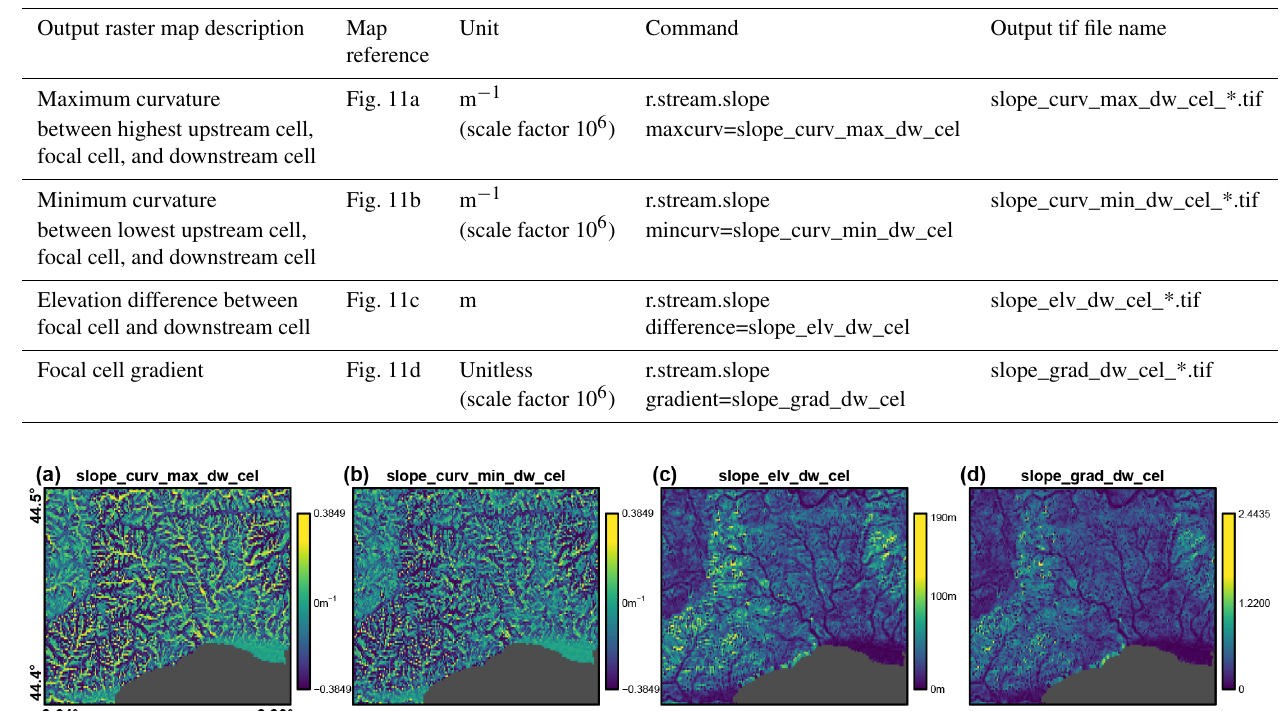
Table 3. Curvature, gradient (elevation difference divided by distance), and elevation difference raster maps computed with the r.stream.slope GRASS GIS module; map reference corresponding to Fig. 11; specific GRASS GIS command; and output layer name.